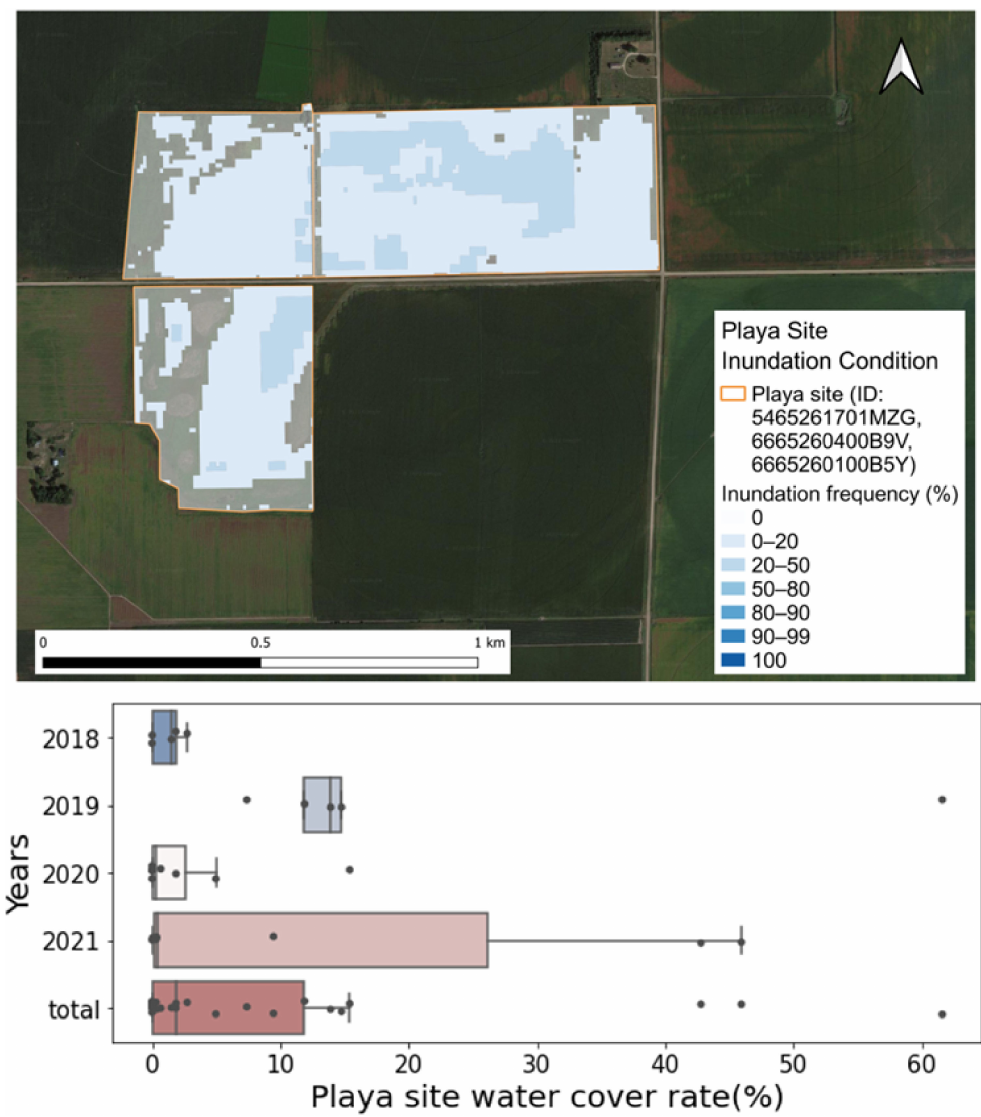
Figure 8. Inundation frequency and surface water cover rate in the playa site. The inundation frequency of the saline site located in northern Lancaster County is illustrated in Figure 10. Saline wetlands are a unique natural resource distributed worldwide. The study site was located within the eastern Nebraska saline wetland area in the Salt Creek watershed. The highest inundation frequency at this site was 76.00%, which covered an area of 226 m 2 , while inundation did not occur in the four years over 92.73% of the site. The highest water cover rate occurred in August 2021 (3.69%), while the lowest of 0% occurred in four months during the four years (May 2018, August 2019, September 2019, and April 2020). The mean water cover rate at the saline site was 0.84%, and the inundation frequency map shows that surface water was limited to a small area at this site. The highest surface water cover rate (1.60%) occurred in